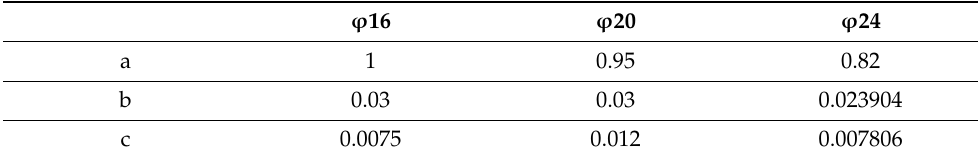
Table 2. Parameter values for the proposed formulation.